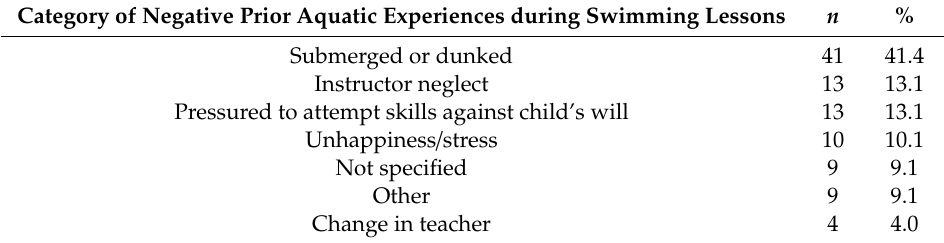
Table 4. Thematic breakdown of negative prior aquatic experiences during swimming lessons ( n = −